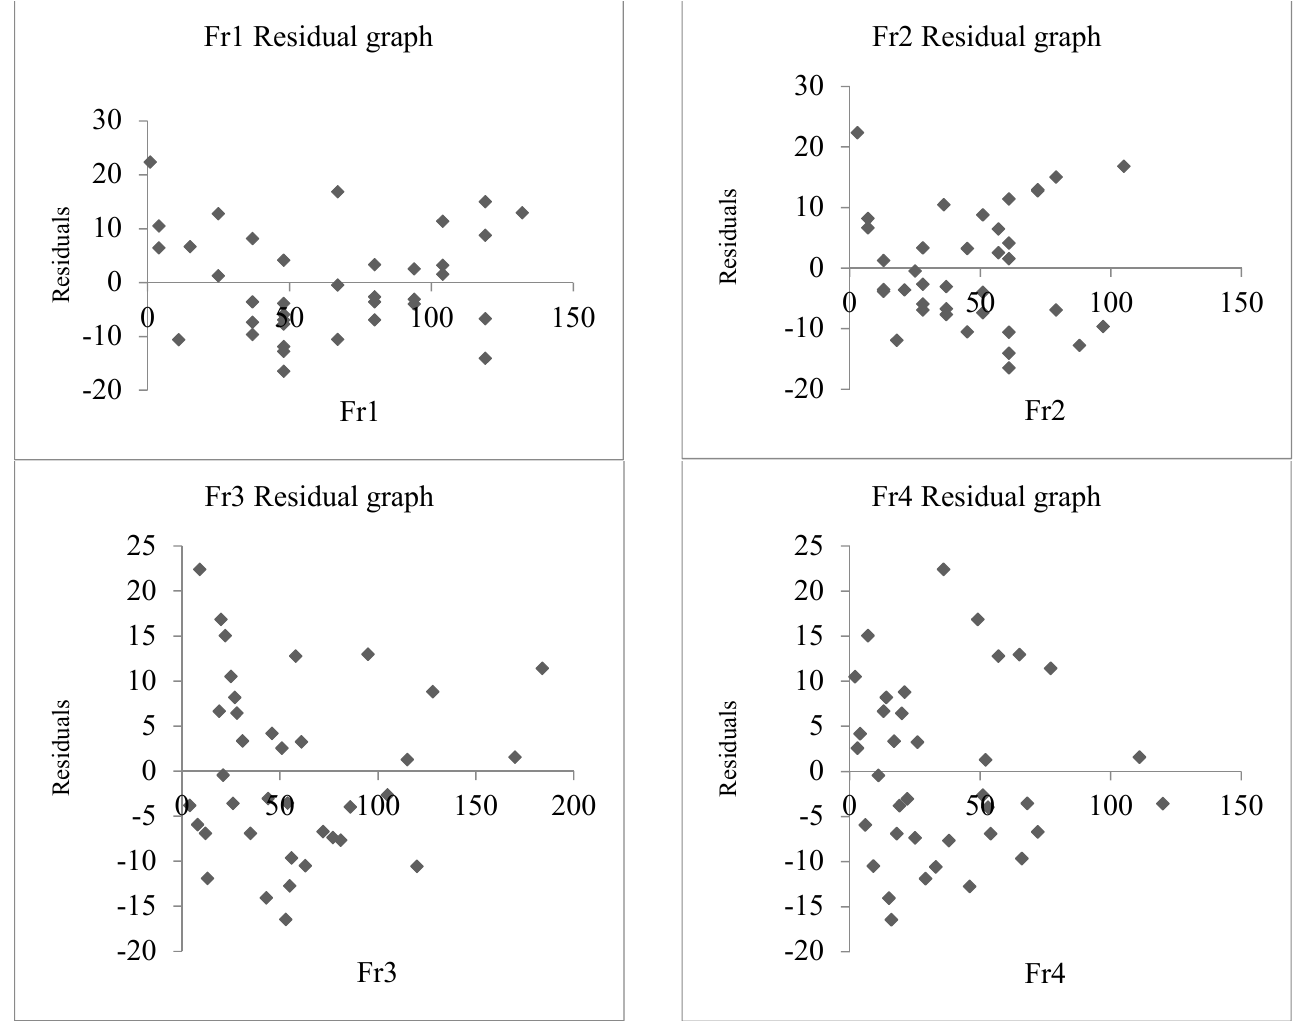
Figure 4. Residual graphs. Source: Obtained by the authors automatically with the help of the “Regression” function in Microsoft Excel.